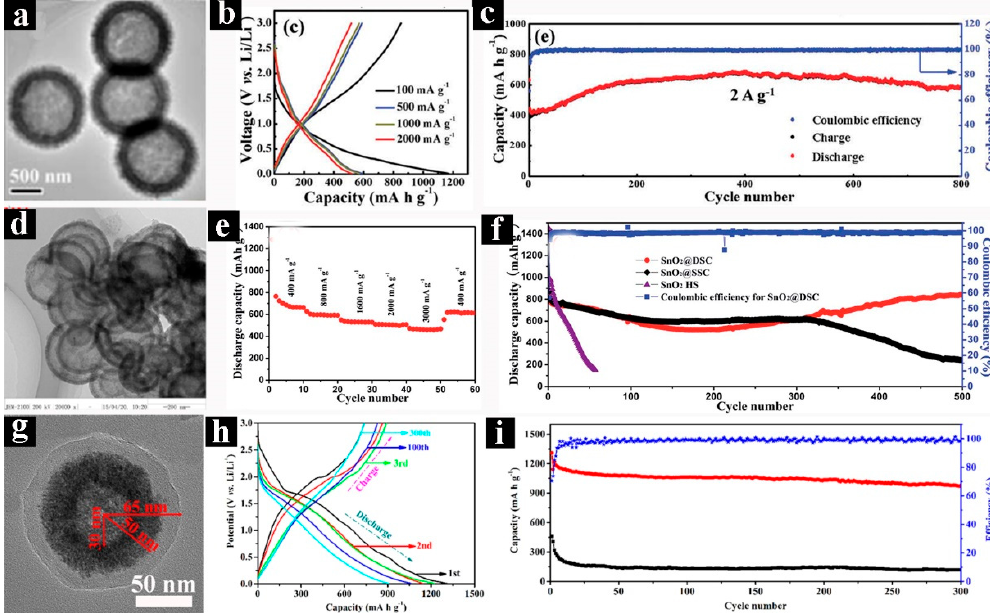
Figure 10. Transmission electron microscopy (TEM) images of hollow and double-shell spheres and their lithium-ion batteries (LIBs) performance: ( a ) TEM image, ( b ) the corresponding charge-discharge curves at di ff erent current densities, and ( c ) long-term cycling performance at a current density of 2 A g − 1 of V 2 O 3 @C hollow sphere. ( d ) TEM image, ( e ) rate capabilities, and ( f ) cycling performance of the SnO 2 @C double-shelled hollow spheres (DSHSs) at 200 mA g − 1 . ( g ) TEM image of CeO 2 @C DSHS, ( h ) the di ff erent cycles discharge and charge profiles of CeO 2 @C DSHS electrodes at 100 mA g − 1 , and ( i ) long cycle stability and CE for 300 cycles at 100 mA g − 1 of CeO 2 and CeO 2 @C electrodes. Pictures ( a ), ( b ), and ( c ) were reprinted with permission from Reference [81]. Copyright the Royal Society Chemistry, 2018. Pictures ( d ), ( e) , and ( f ) were reprinted with permission from Reference [114]. Copyright the Royal Society Chemistry, 2015. Pictures ( g ), ( h ), and ( i ) were reprinted with permission from Reference [118]. Copyright the Royal Society Chemistry, 2018.